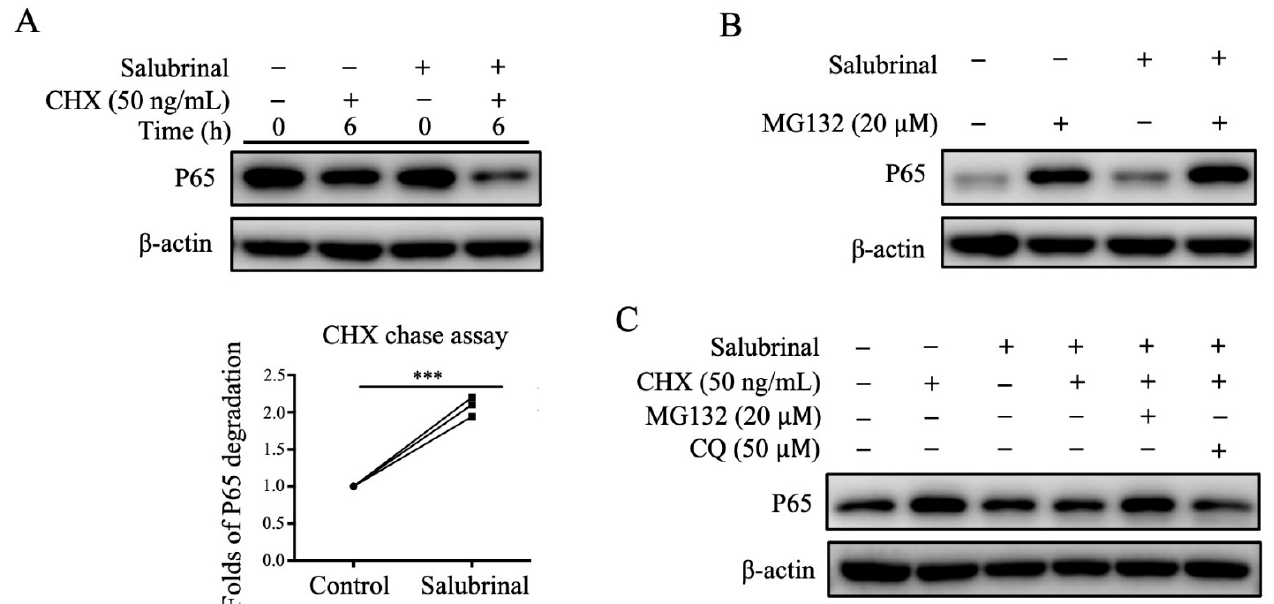
Figure 5. Salubrinal promoted P65 degradation through the ubiquitin-proteasome system. Bone marrow-derived osteoclast precursors were pre-incubated with Salubrinal (10 µM) for 3 h, induced with RANKL (30 ng/mL) for 30 min, washed with PBS, and treated with CHX ( A ), MG132 ( B ), or CHX + MG132/CQ ( C ) for 6 h. The abundance of p65 protein was analyzed by Western blotting. Data are shown as means ± SEM. *** p < 0.001.